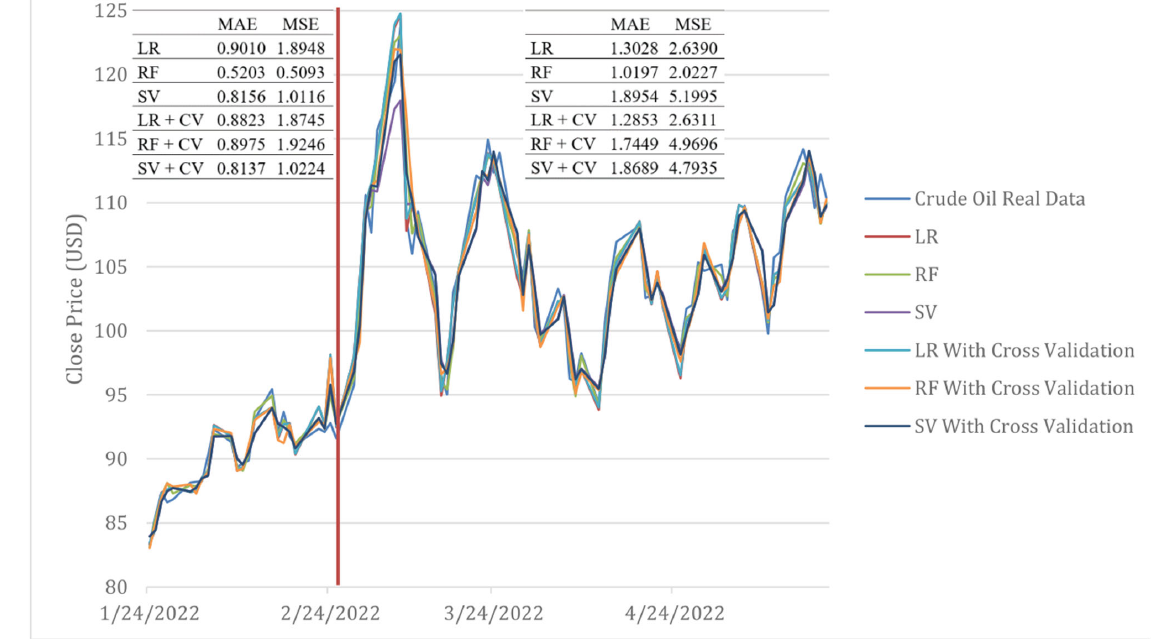
Figure 5. Results for four months without the effect of war.